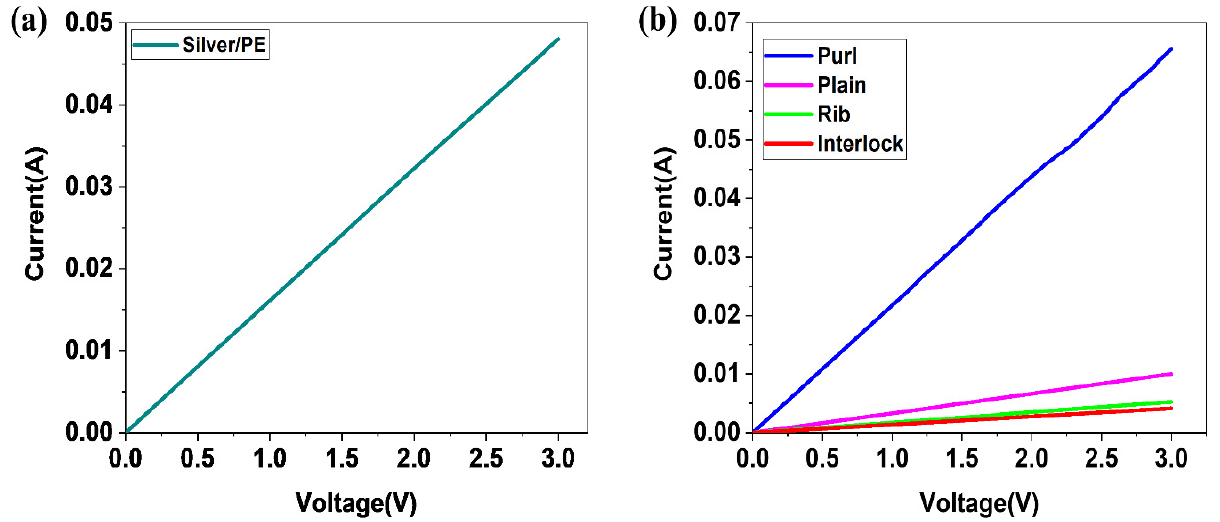
Figure 5. Current–voltage ( IV ) curves ( a ) silver/PE yarn, ( b ) different knitted structures.